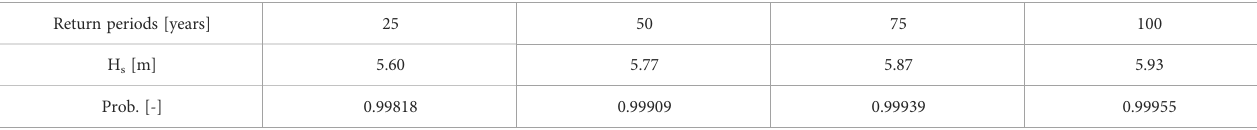
TABLE 5 Signi fi cant wave height in extreme sea states in the Mediterranean, from Hüsken et al. (2019). Return periods